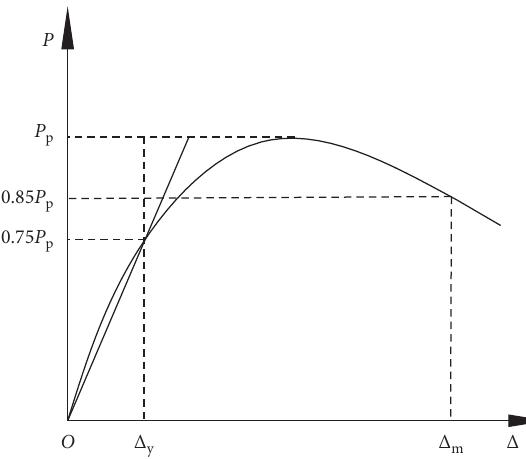
Figure 11: Calculation method of yield displacement and maximum